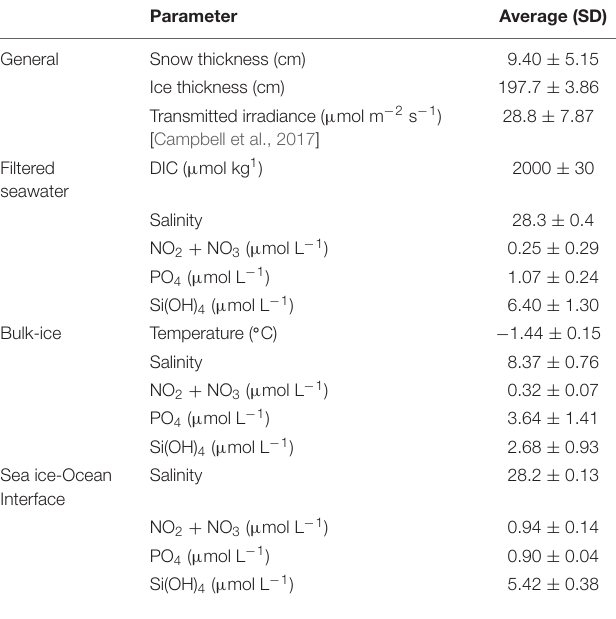
TABLE 1 | Average values with standard deviation (brackets) for environmental and oceanographic parameters at the study location in Dease Strait, sampled between 17 May and 9 June ( n =